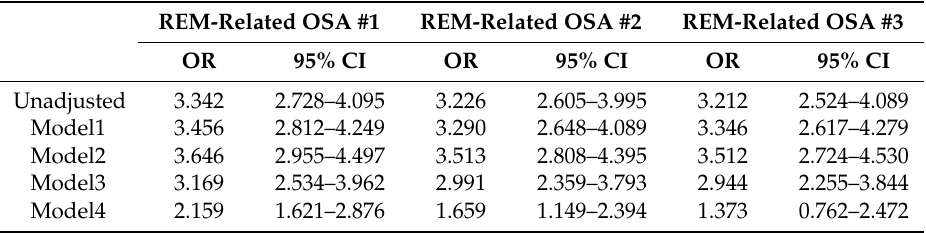
Table 3. Association between REM-related OSA and female sex. REM-Related OSA #1 REM-Related OSA #2